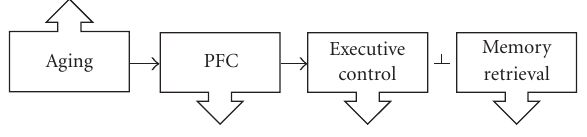
Figure 1: Increasing age leads to decreased prefrontal function, which decreases executive control, in turn blocking (perpendicular line) controlled memory retrieval.